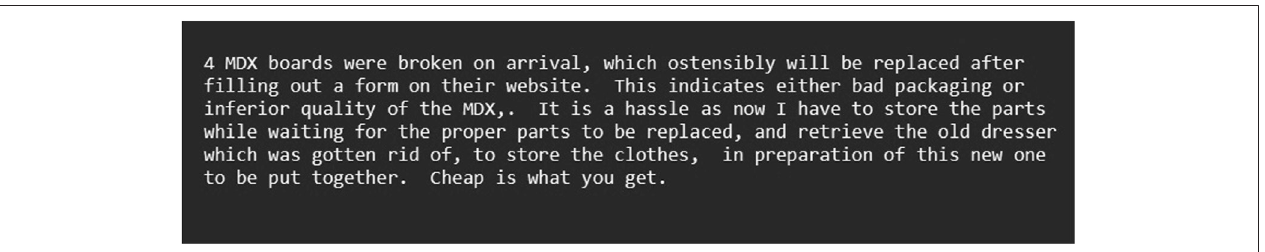
FIGURE 3 | Simple OCR before text preprocessing